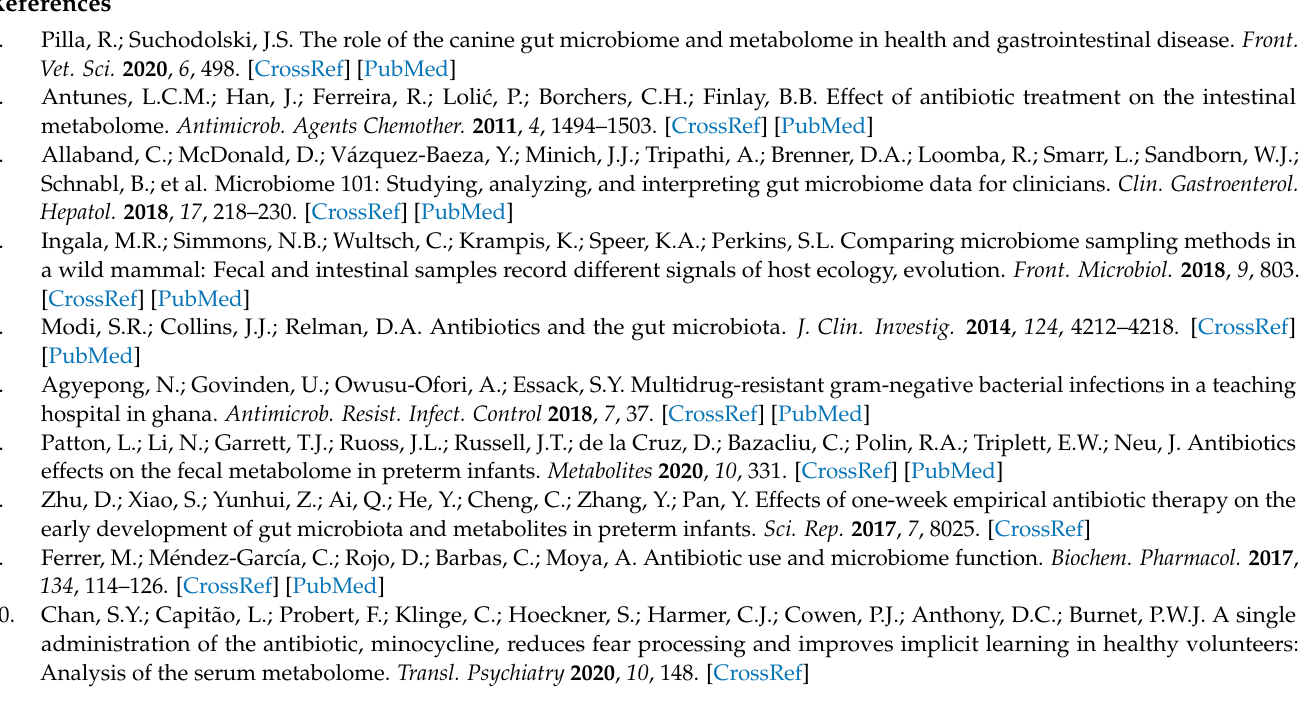
metabolomics. Table S2: List of metabolites identified in serum samples by untargeted metabolomics. Mean and standard deviation by group and time point. Table S3: List of raw metabolites identified in fecal samples by targeted metabolomics. Table S4: List of metabolites identified in fecal samples by targeted metabolomics. Mean and standard deviation by group and time